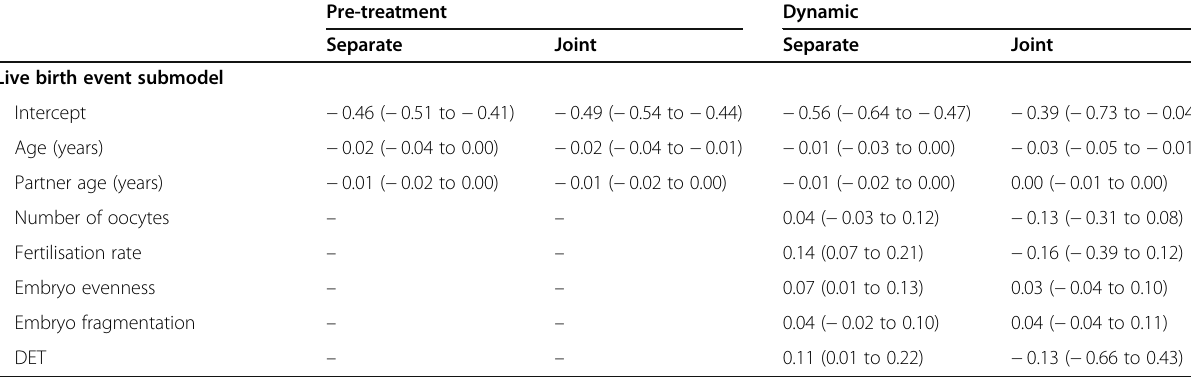
Table 2 Estimated regression coefficients (95% CIs) from the fitted models (Continued)